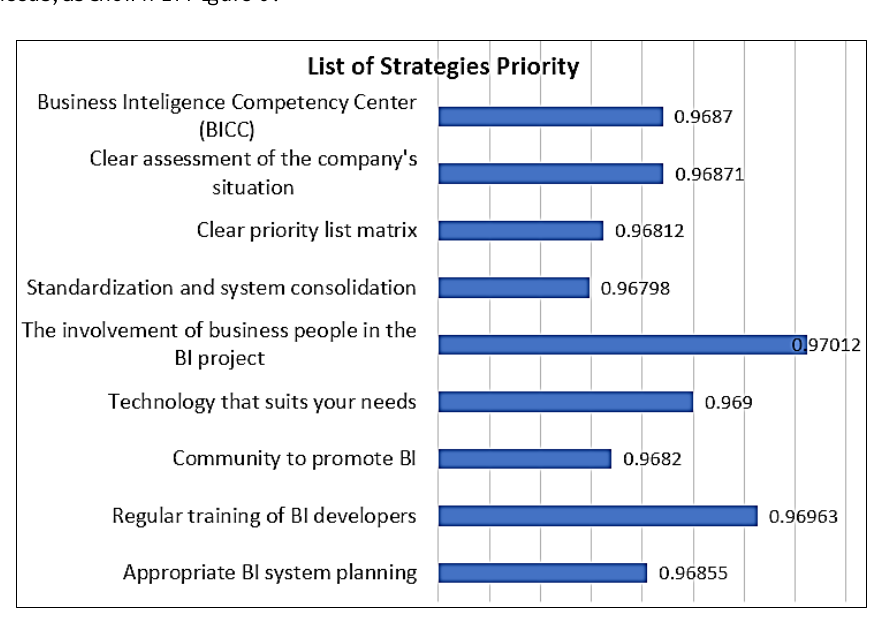
Figure 6. Strategy